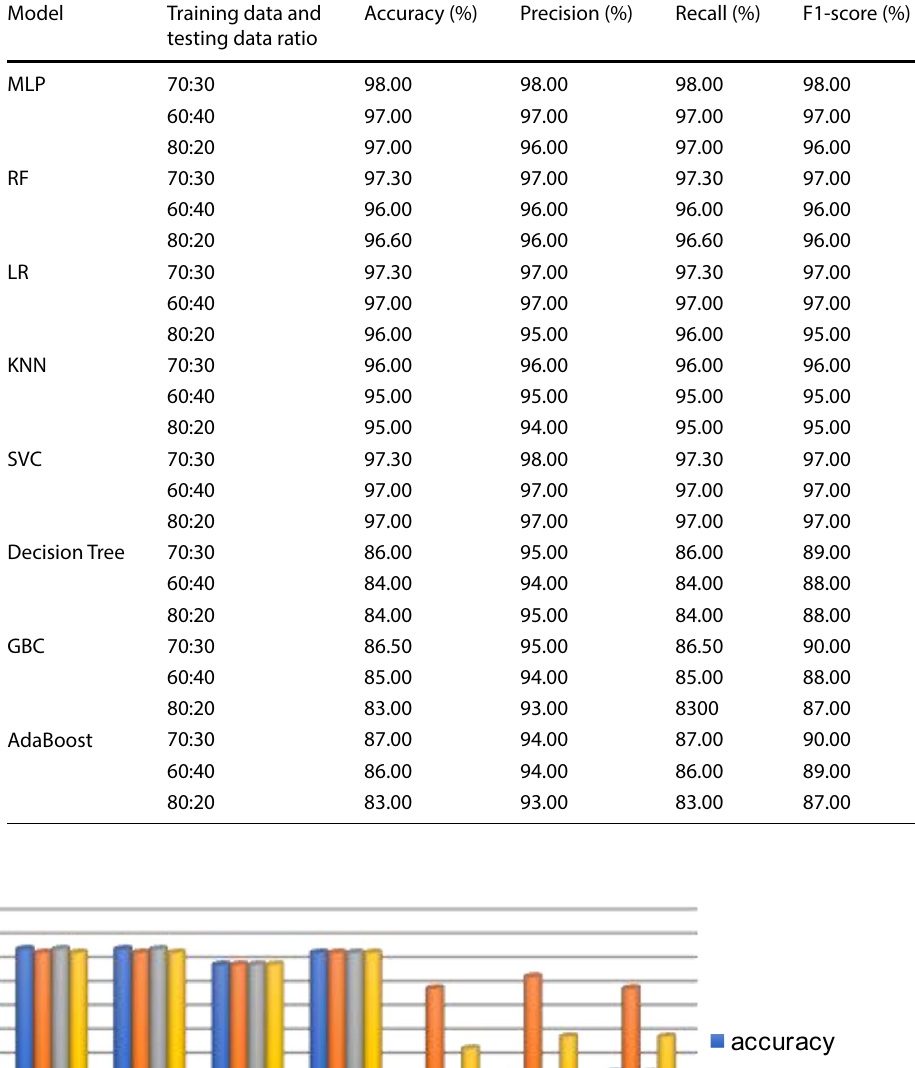
Table 5 Performance comparison of different classification algorithms on top 25 features